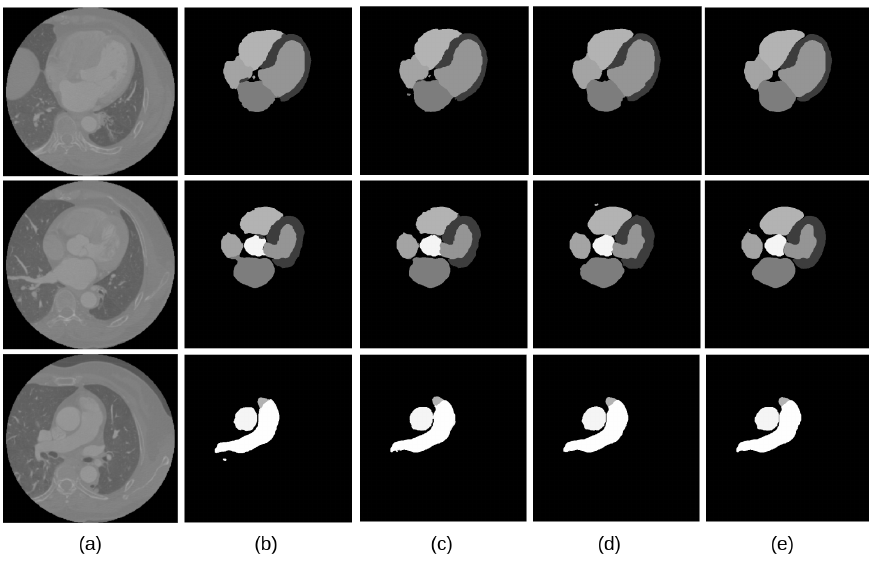
Figure 10. Comparison of the results of four different network architectures. ( a ) the input original CT image; ( b ) segmentation results of Pre-ResNet without VAE; ( c ) segmentation results of Pre-ResNet with VAE; ( d ) segmentation results of FM-Pre-ResNet without VAE; ( e ) segmentation results of proposed FM-Pre-ResNet with VAE obtains the most accurate results on the testing dataset.